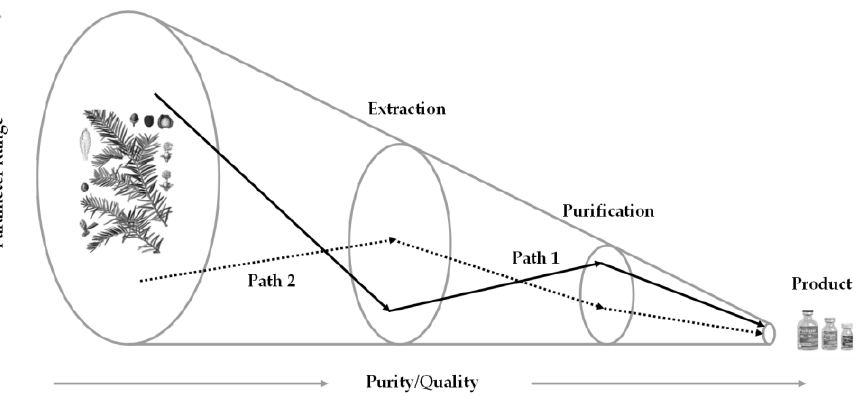
Figure 2. Basic idea of design spaces in phytoextraction [13].